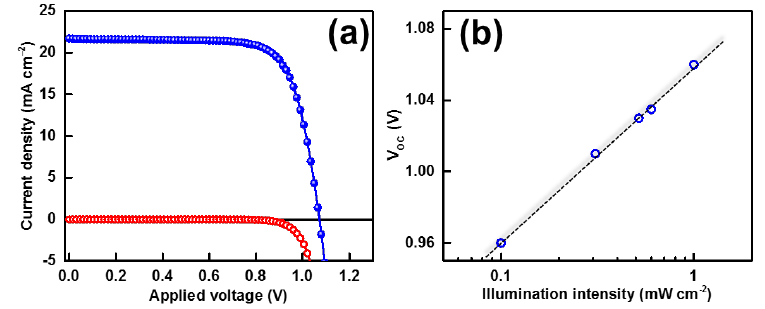
Figure 2. ( a ) Dark and light J-V characteristics of the MAPbI 3 PSC recorded under standard test conditions and ( b ) open circuit voltage of the device measured under various illumination levels.